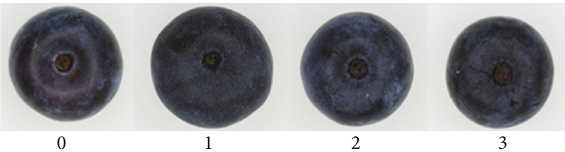
Figure 1: Fruit dehydration degree visually observed following the norms for quality of fresh blueberries from Chilean Blueberry Committee (CBBC, 2011).